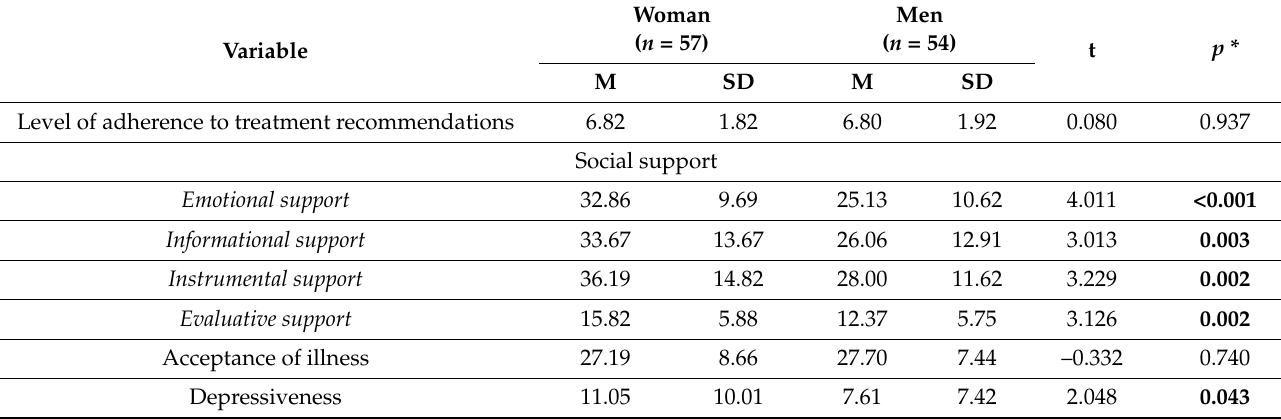
Table 2. Adherence to therapy, social support according to the ISSB, acceptance of disease according to the AIS, and depression according to the BDI among the liver transplant patients by